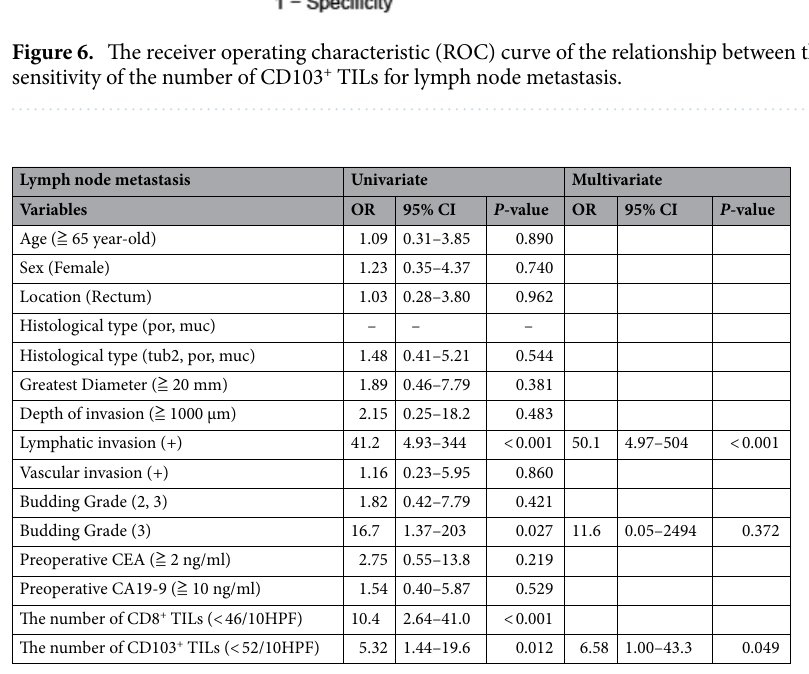
Table 3. Factors evaluated for lymph node metastasis (univariate and multivariate analyses). OR odds ratio, CI confidence interval, CEA carcinoembryonic antigen, CA19-9 Carbohydrate Antigen 19–9, CD cluster of differentiation, TIL tumor-infiltrating lymphocytes, HPS high-power